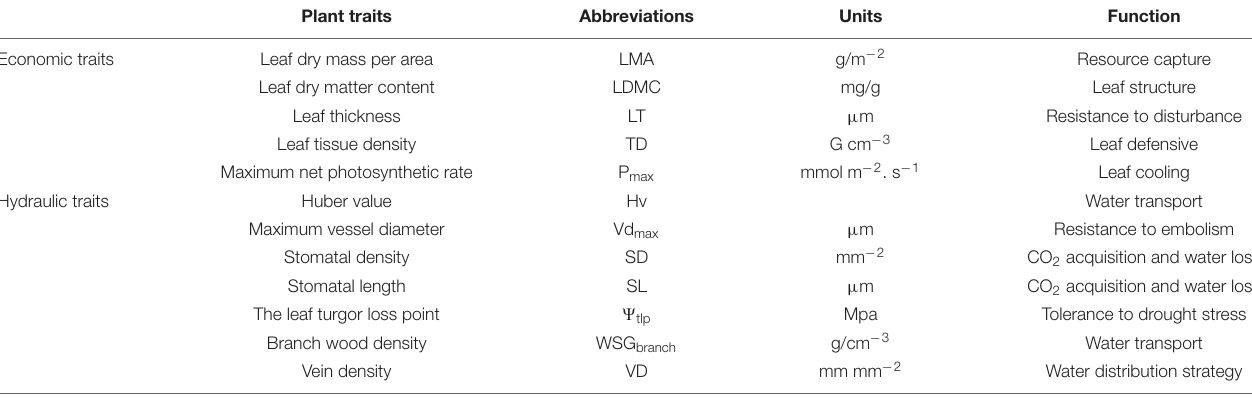
TABLE 2 | Functional traits employed in this study as well as their abbreviations, units, and functions. Plant